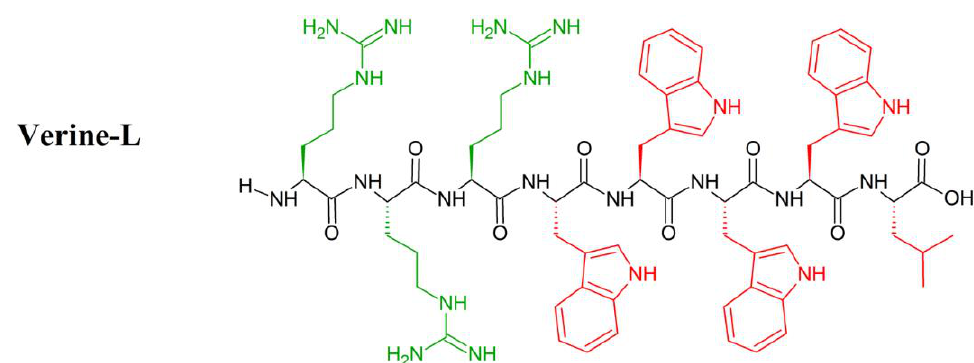
Figure 1. Primary structure of Temporin_SHf and its artificial analogues: TetraF2W-RR, Horine and Verine-L. Amino acid side chains are colored in red (hydrophobic), blue (hydrophilic) and green (positively